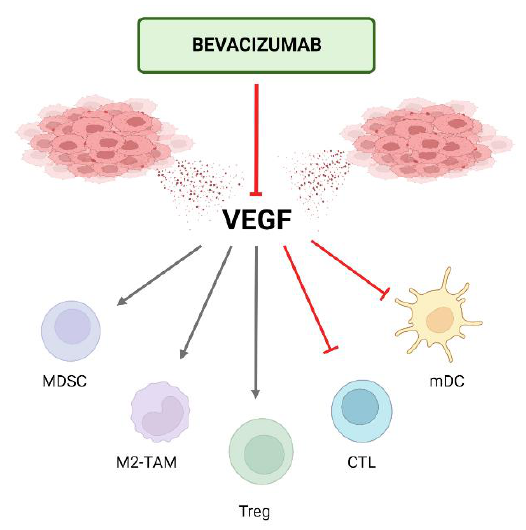
Figure 1. Direct effects of VEGF on different types of immune cells. VEGF, which is secreted by tumor and stromal cells, directly increases the proliferation of MDSCs, Tregs, and M2-like TAMs that have immunosuppressive functions and inhibit the proliferation or maturation of CTLs and mDCs that have immunoactivating functions. As a result, VEGF creates an immunosilenced tumor microenvironment. Bevacizumab can counteract these actions and, therefore, turn the immunosup- pressed toward an immunoactive tumor microenvironment. VEGF: vascular endothelial growth factor; MDSC: myeloid-derived suppressor cell; Treg: regulatory T-cell; TAM: tumor-associated macrophage; CTL: cytotoxic T-cell; mDC: mature dendritic cell. Created with Biorender.com; no copyright issue.